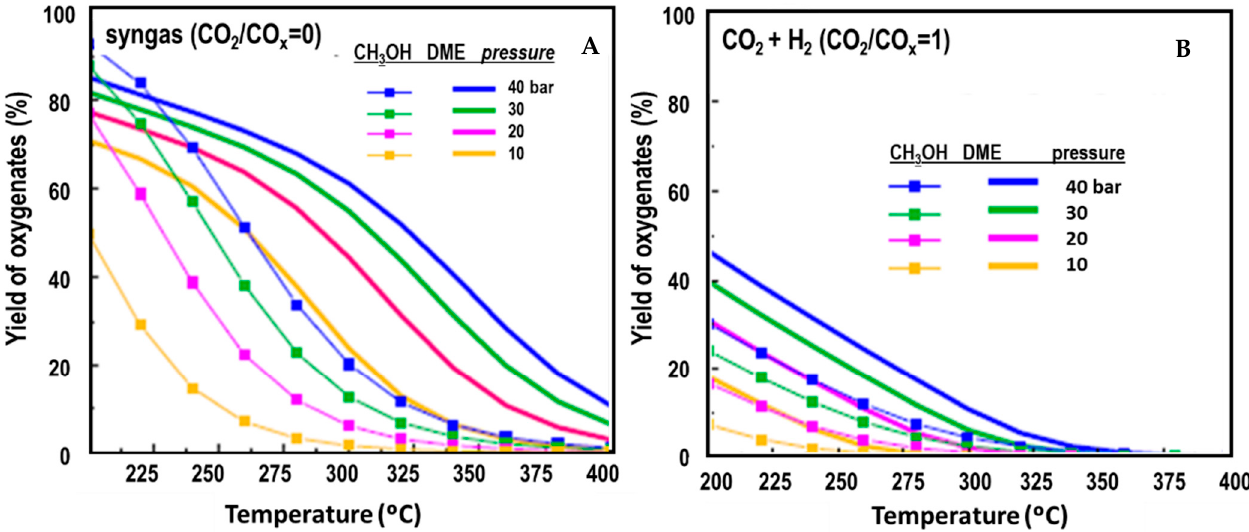
Figure 2. Effects of temperature and pressure on the yield of methanol and dimethyl ether (DME) in the thermodynamic equilibrium of the direct synthesis of methanol and DME from syngas ( A ) and CO 2 ( B ) (adapted from [31] with permission from Elsevier License No. 5015221187364).